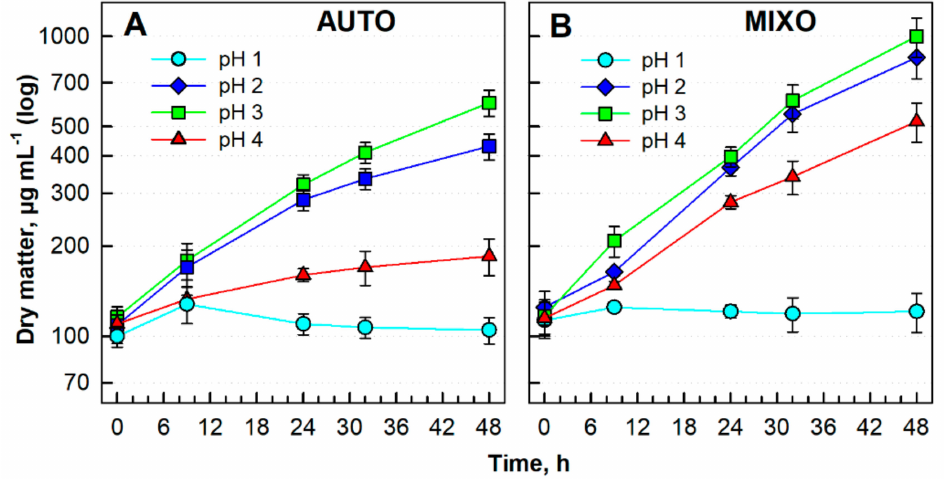
Figure 2. Growth of Galdieria sulphuraria under auto- ( A ) and mixotrophic ( B ) regimes at different pH (pH 1-cyan circles, pH 2-blue diamonds, pH 3-green squares, pH 4-red triangles), at a light intensity of 500 µ mol photons m − 2 s − 1 and temperature of 40 ◦ C, expressed as dry matter (DM) in µ g mL − 1 . For mixotrophic growth, 1% glycerol was added. The data are plotted as means of biological triplicates. The error bars represent standard deviations ( ± SD) and are shown when larger than the symbol